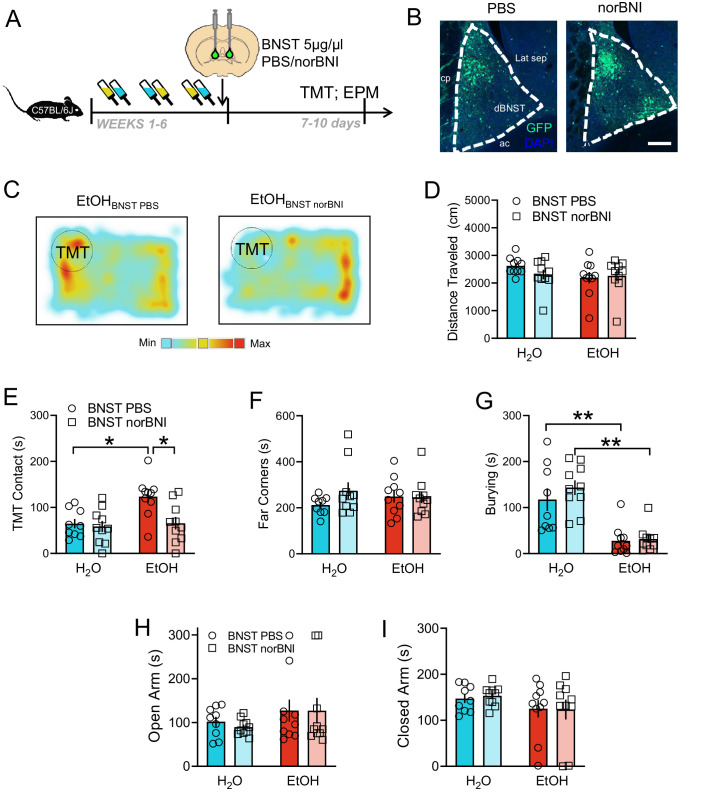
Role of BNST KOR in responses to predator odor after alcohol.(A) Experimental design for 5 µg/µl norBNI in the BNST. (B) Representative images of BNST infusions of PBS (n = 9 H2O, n = 10 EtOH) and norBNI (n = 10 H2O, n = 10 EtOH) marked with GFP. Scale bar indicates 200 µM. (C) Representative heatmaps of TMT-induced activity with EtOH BNST PBS (left) and EtOH BNST norBNI (right). (D) Distance traveled during the TMT test. (E) TMT contact (sec), (F), time spent in the far corners (sec), and (G), burying (sec) during the TMT trial. Time spent in the (H), open arms (sec) and (I) closed arms (sec) of the elevated plus maze. *p<0.05. **p<0.01.